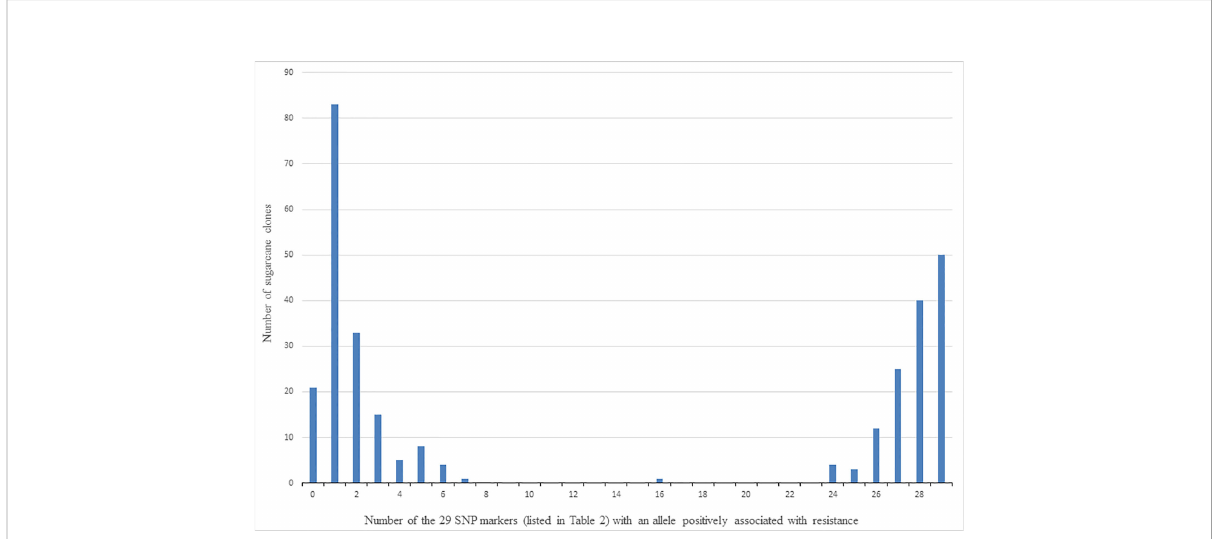
FIGURE 6 Number of clones (out of 305) versus number of the 29 SNP markers listed in Table 2 that detected the allele (for each marker) associated with resistance to red